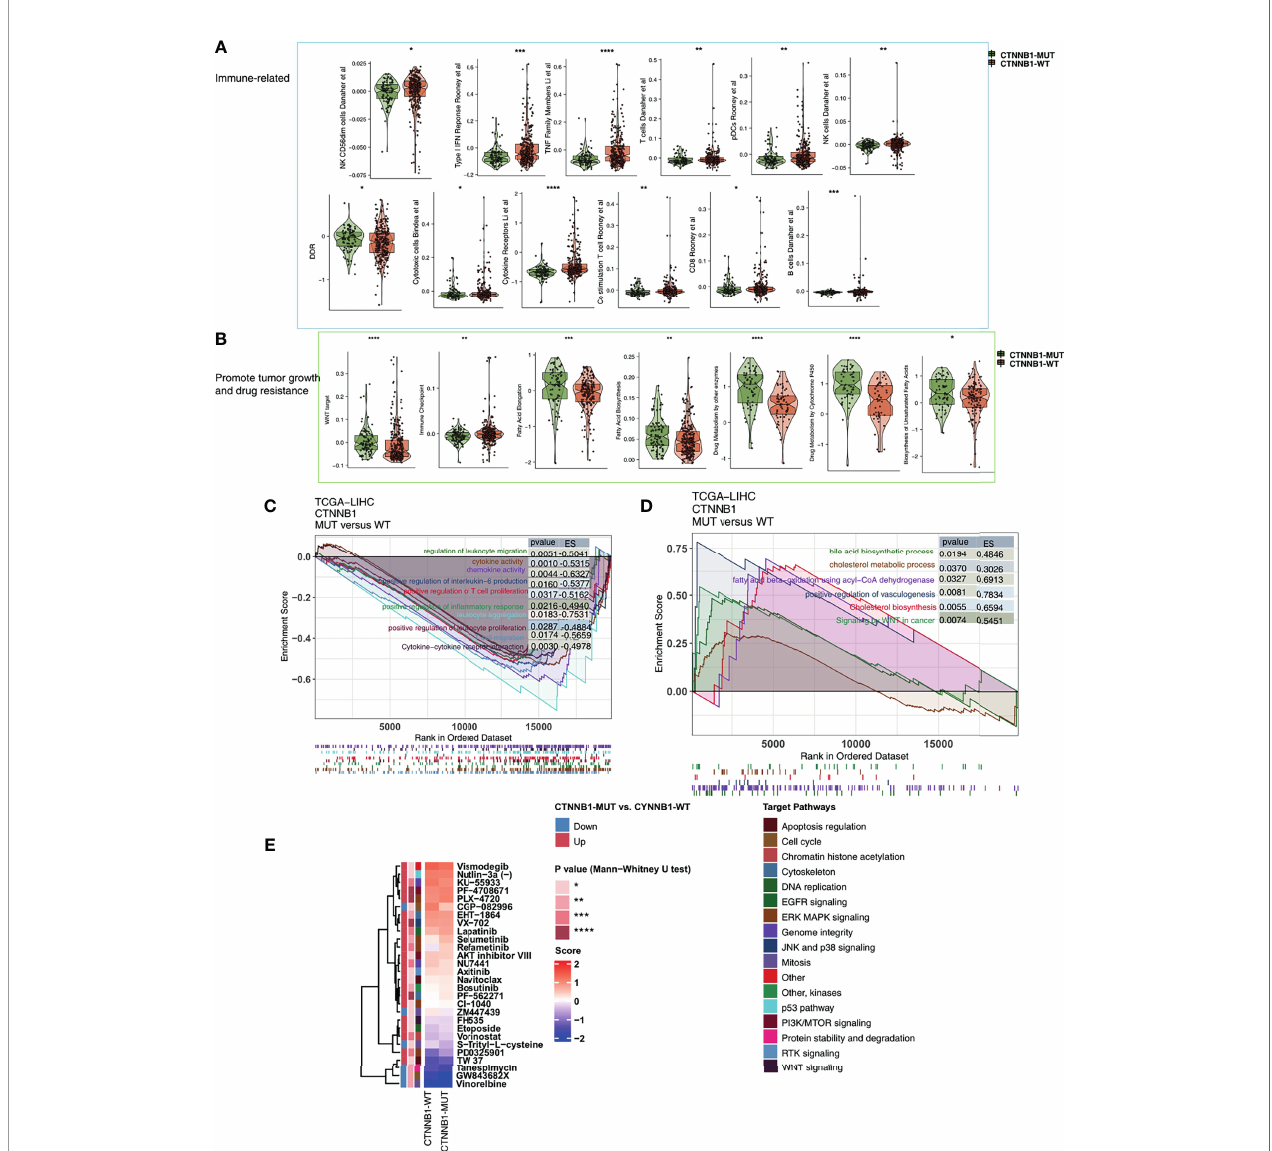
FIGURE 6 | The transcript traits between CTNNB1-MUT and CTNNB1-WT. Comparison of immune-related (A) , metabolic-related, and tumor-related signatures (B) between CTNNB1-MUT and CTNNB1-WT tumors in the TCGA-LIHC cohort. The results of GSEA in the TCGA-LIHC cohort relating to immune signaling (C) and immune-exhausted signaling (D) . The color of the curve corresponds to the font color of the pathway. The GSEA of hallmark gene sets was downloaded from the MSigDB and each run was performed with 1000 permutations. Enrichment results with signi fi cant differences between CTNNB1-MUT and CTNNB1-WT tumors are shown. (E) Comparison of IC50 value of drugs estimated by the pRRophetic algorithm between CTNNB1-MUT and CTNNB1-WT in the TCGA-LIHC cohort. *P < 0.05; **P < 0.01; ***P < 0.001; ****P <